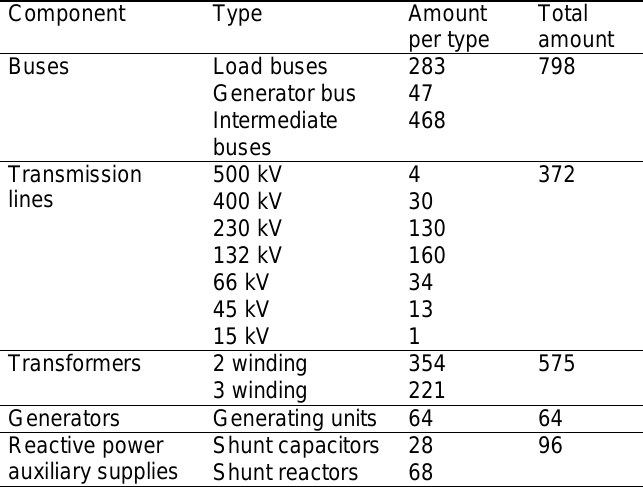
Table 1: Size of the EEP system taken for